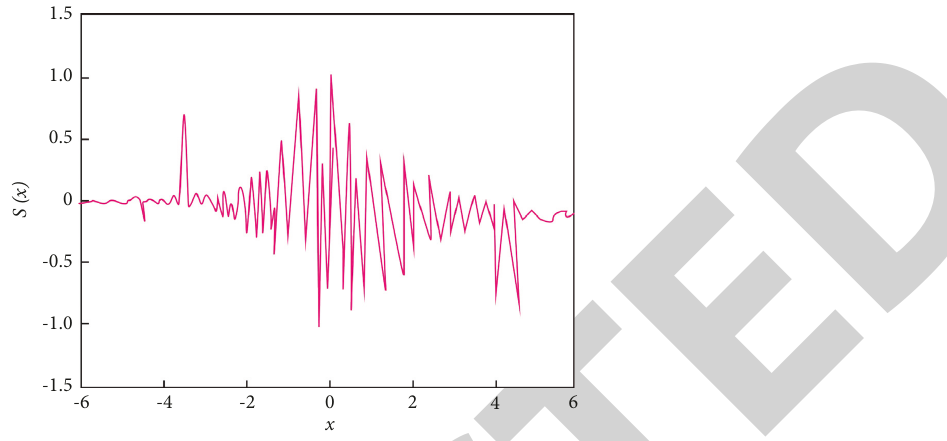
Figure 1: BP neural network function